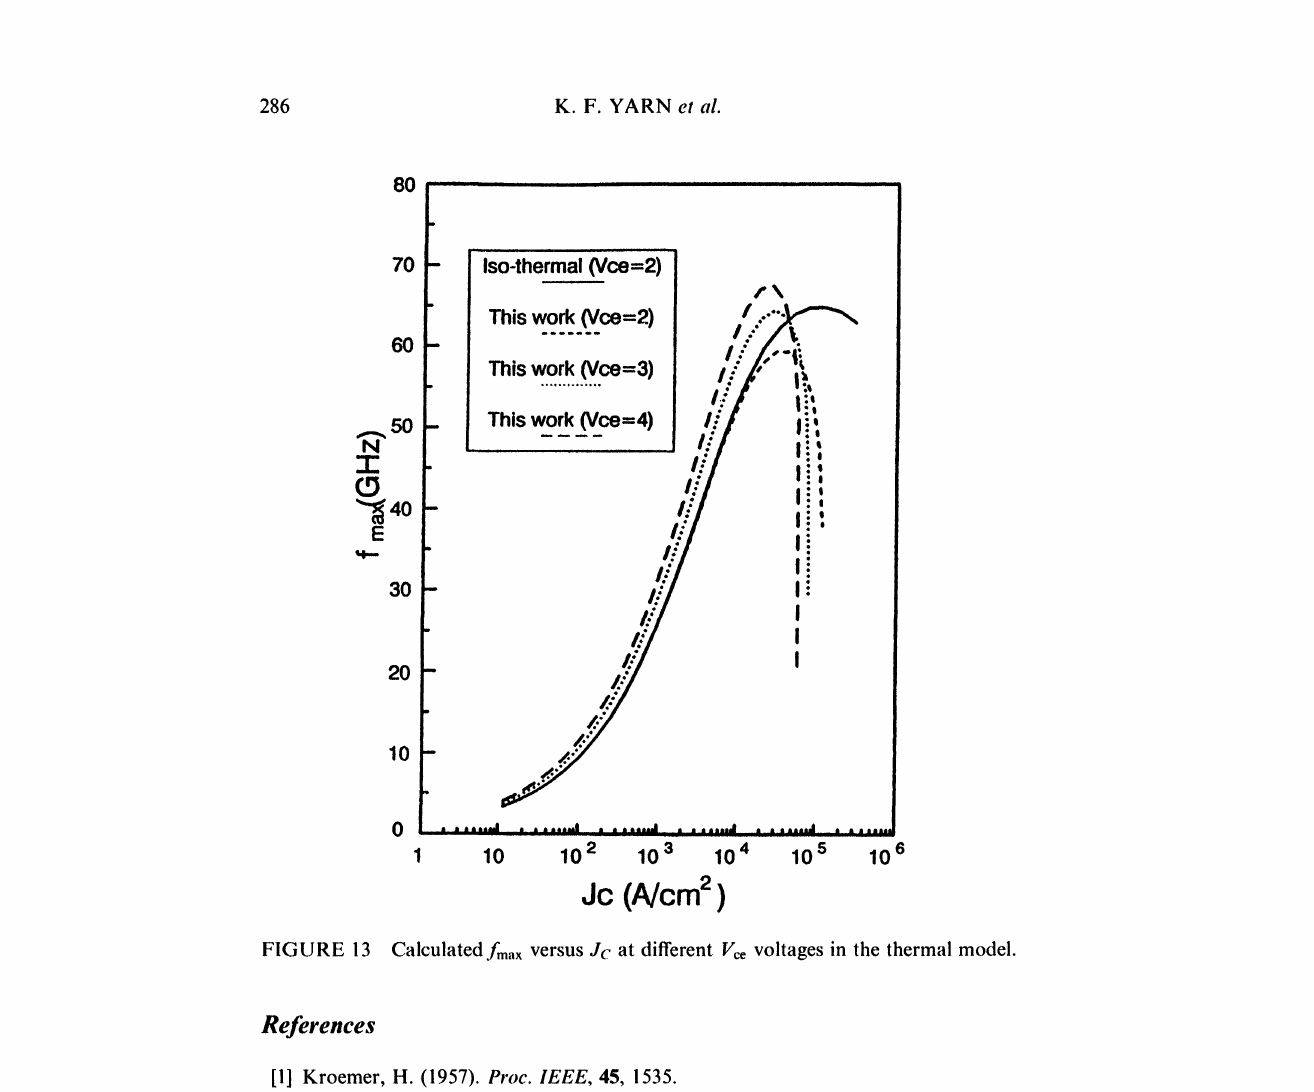
FIGURE 13 Calculatedfmax versus Jc at different Vce voltages in the thermal